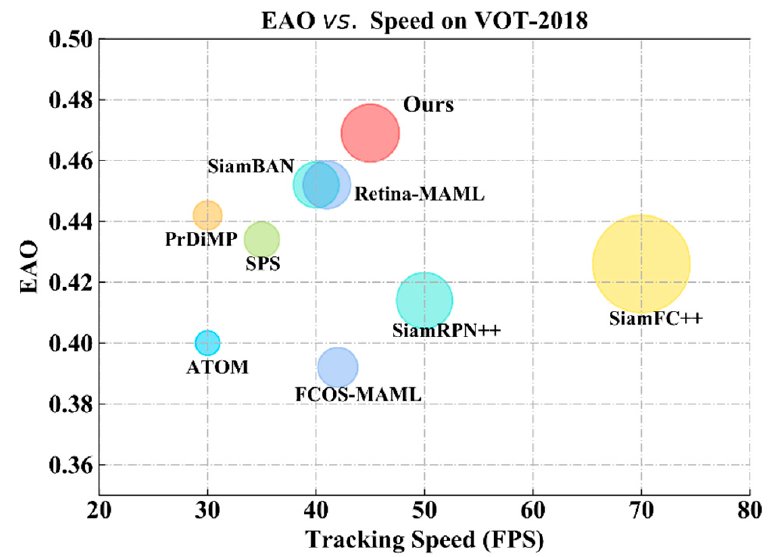
Figure 7. Comparisons of EAO and speed on VOT2018 benchmark.